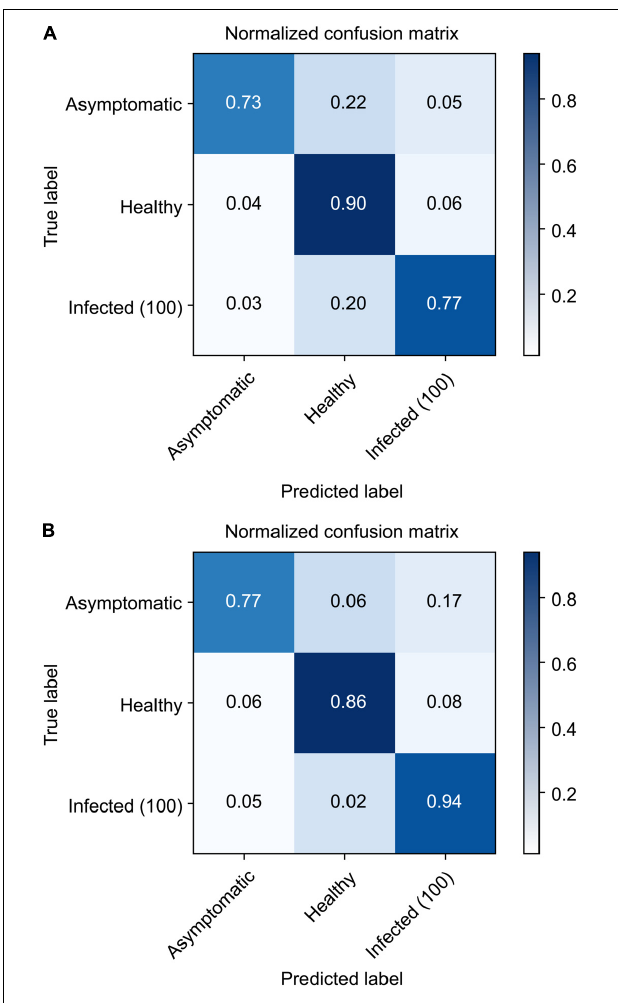
FIGURE 14 | Confusion matrix results from the trained 3D CNN model to infer the test set [raw 3D CNN (A) ; extended input 3D CNN (B) ].